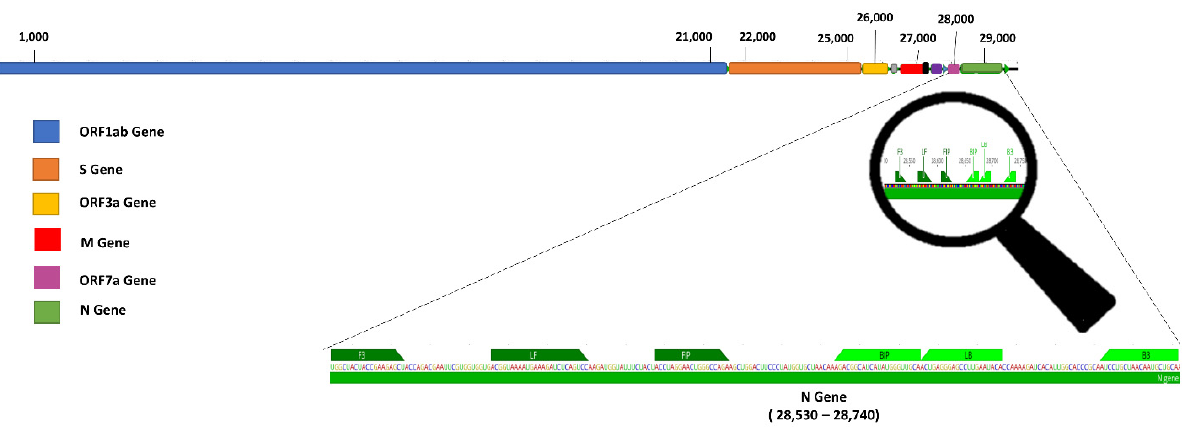
Figure 2. Design of N-gene-specific primer sets for SARS-CoV-2 (Table 1), designed to selectively amplify the 28,530–28,740 nucleotide segment. Their corresponding positions are demonstrated in the magnification of the image. Table 1. Sequence of primers for RT-LAMP with target gene N according to references 23,30 .